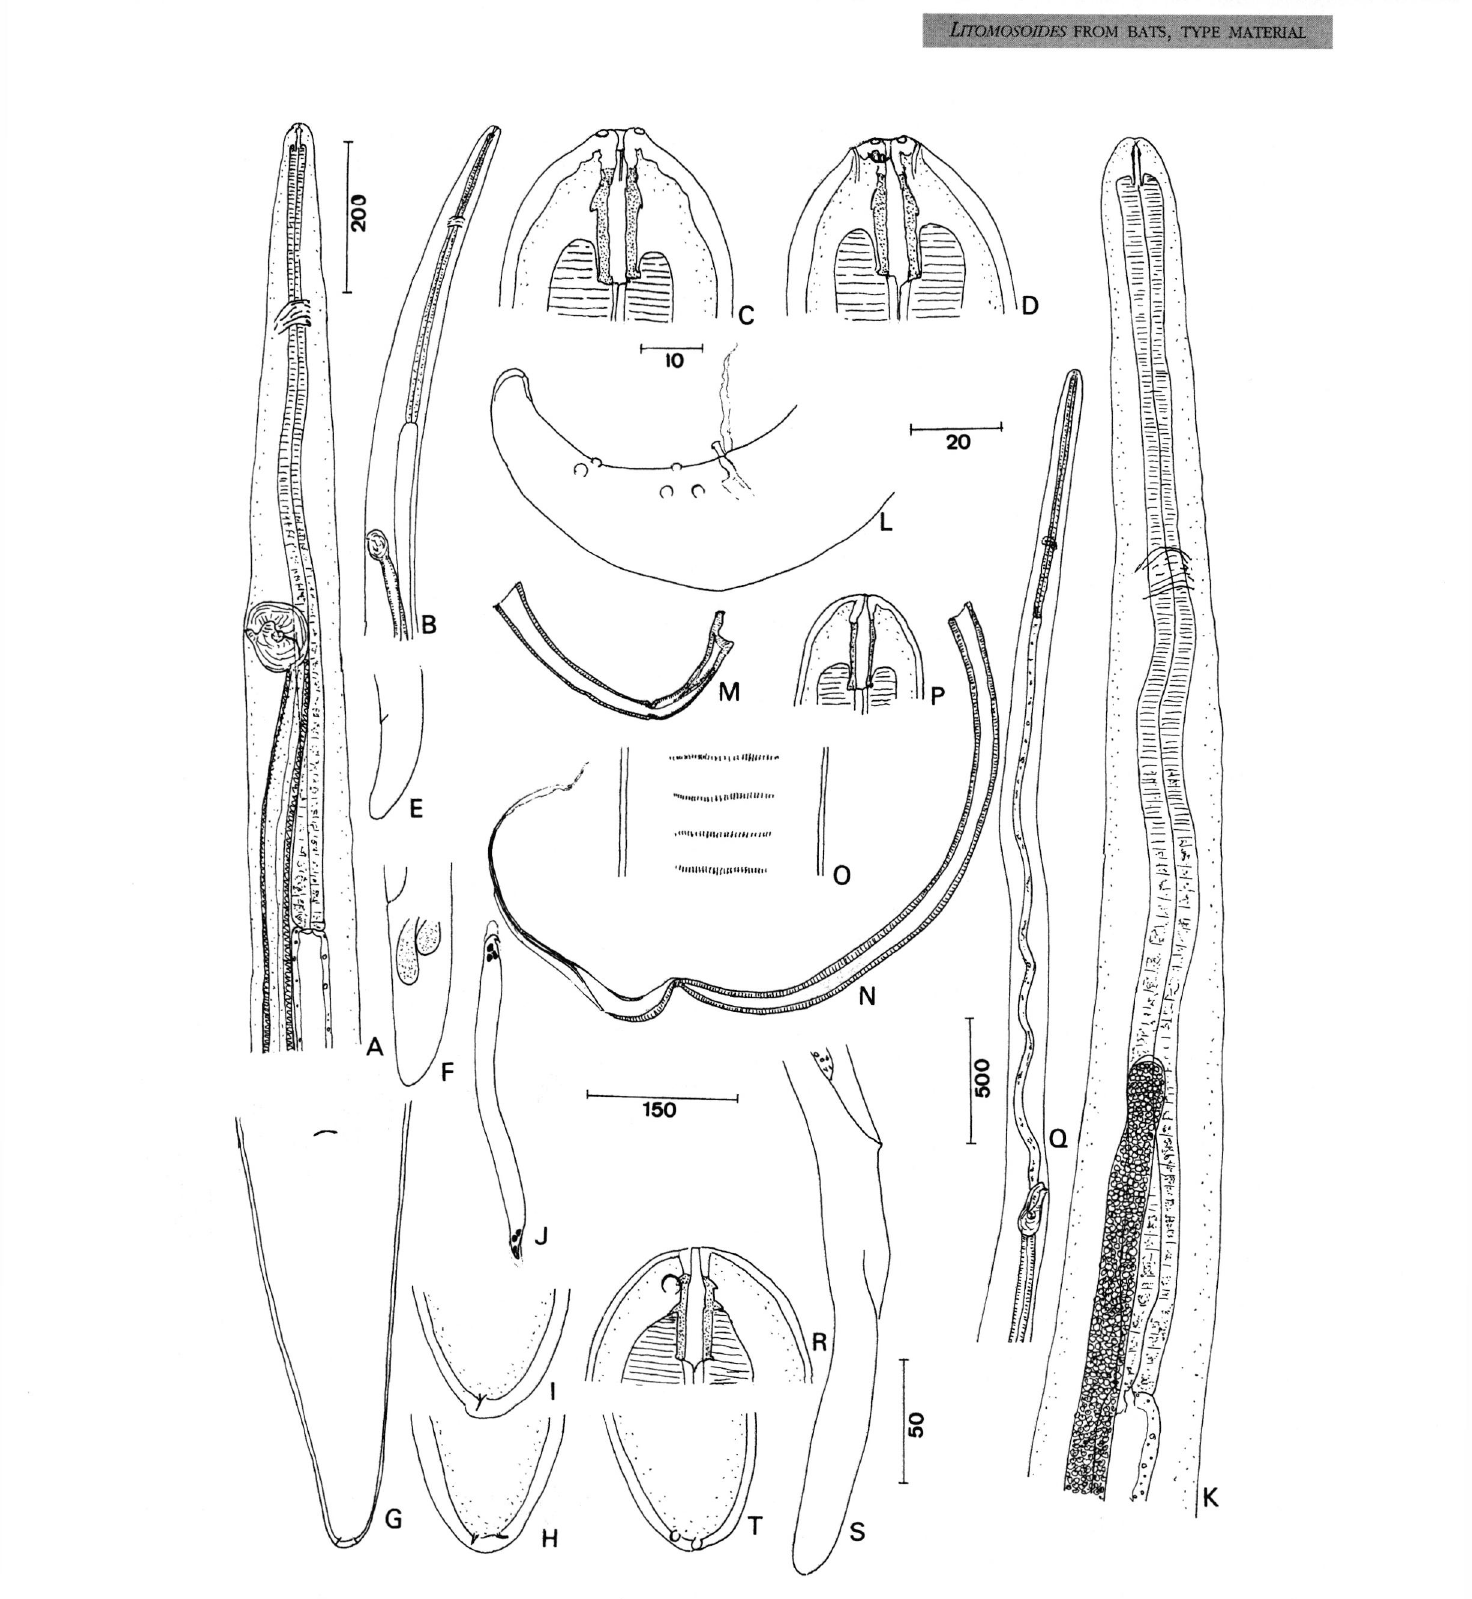
Fig. 2. - Type material of Jiménez-Quiros & Arroyo, 1960, including Litomosoides hamletti penai and a female of L. brasiliensis. A to G. L. h. penai, female. A & B, anterior region showing extreme positions of vulva, left lateral view. C & D, head of two specimens, respec tively lateral and ventral views. E & F, tail of two specimens, left lateral view (apex of ovaries indicated on F). G, other specimen, tail, ventral view. H & I, other specimen, caudal extremity, lateral and ventral views. J, uterine microfilaria. K to P, L. h. penai, male allotype. K, anterior region, median view. L, tail, left lateral view. M, right spicule, right lateral view. N, left spicule, left lateral view. O, area rugosa, ventral view. P, buccal capsule. Q to T, L. brasiliensis, female. Q, anterior region, lateral view . R, buccal capsule, left lateral view (a cephalic papillae is identified). S, tail, right lateral view. T, caudal extremity, ventral view. Scale bars: A, E, F, S, 150 µm; B. 200 pm; C, D. J. 10 µm; G, T. 50 µm; I. H, L, M, N, O. P. R. 20 µm; Q. 500